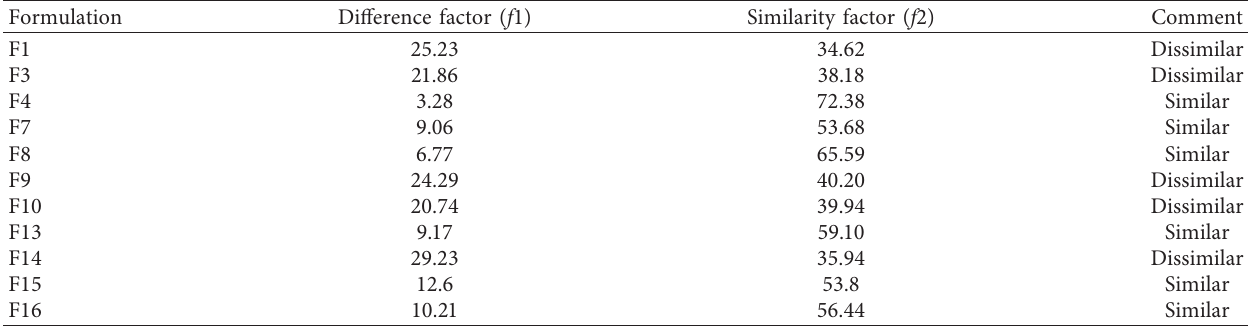
Table 5: Difference ( f 1) and similarity ( f 2) factors of formulated